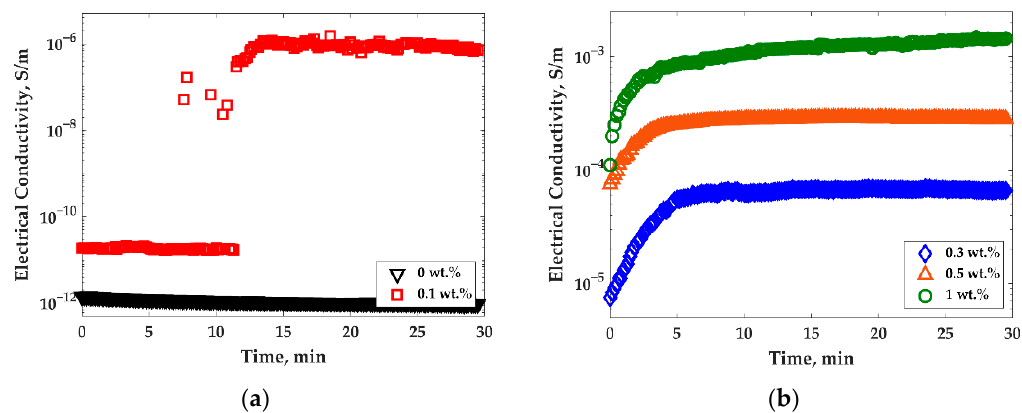
Figure 12. Electrical conductivity as a function of time for PP/PS/MWCNTs composite with different concentrations of MWCNTs measured every 10 s at 1 Hz of frequency and 135 °C for: ( a ) 0–0.1 wt.% of MWCNTs; and ( b ) 0.3–1 wt.% of MWCNTs.